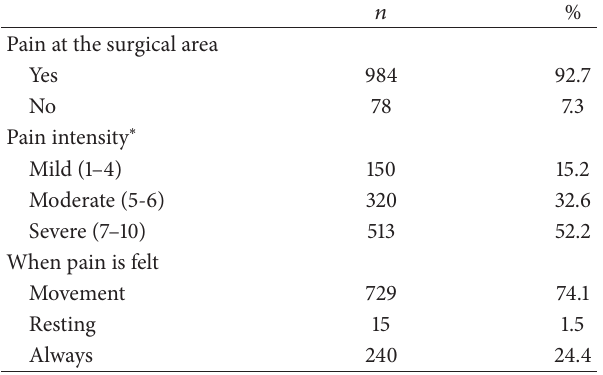
Table 2: Characteristics of preoperative pain in women after cesarean